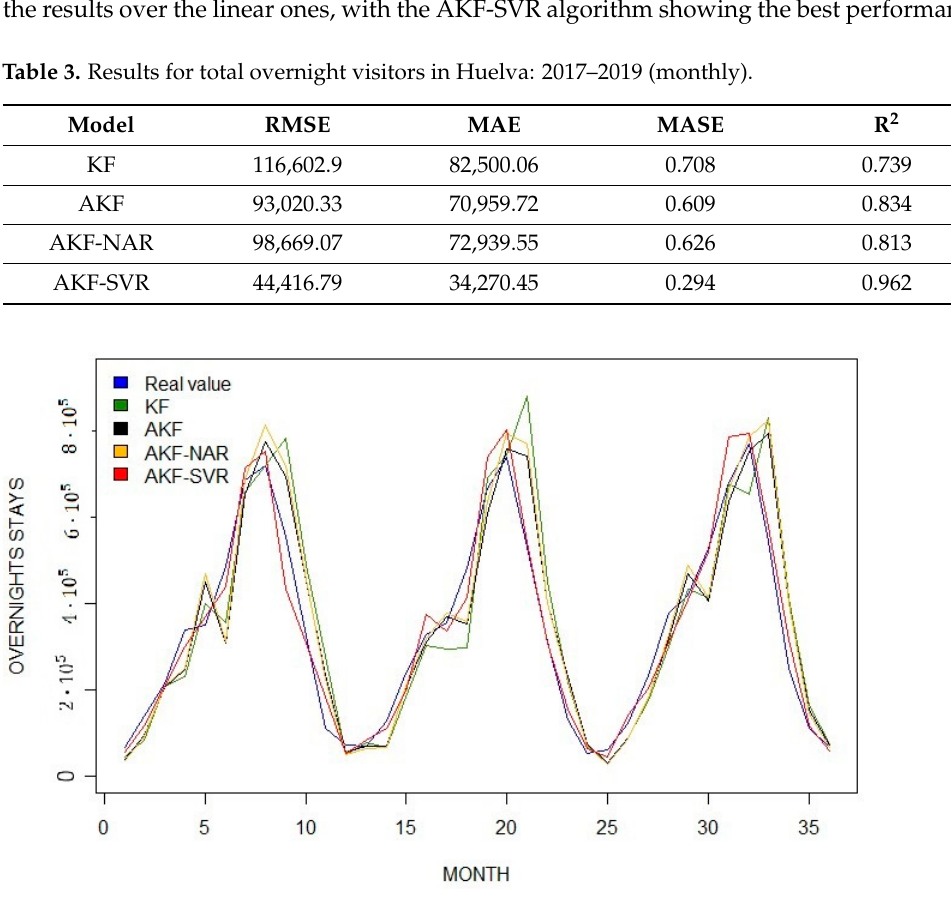
Table 3. Results for total overnight visitors in Huelva: 2017–2019 (monthly).